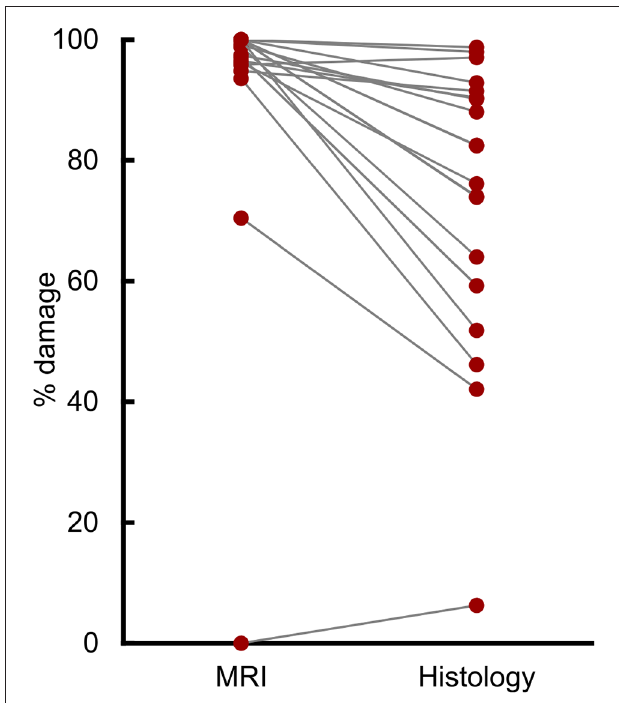
FIGURE 1 | T2 magnetic resonance imaging (MRI) overestimated amygdala damage. Percent damage for each of 19 hemispheres as assessed by T2 MRI hypersignal and by histological examination.